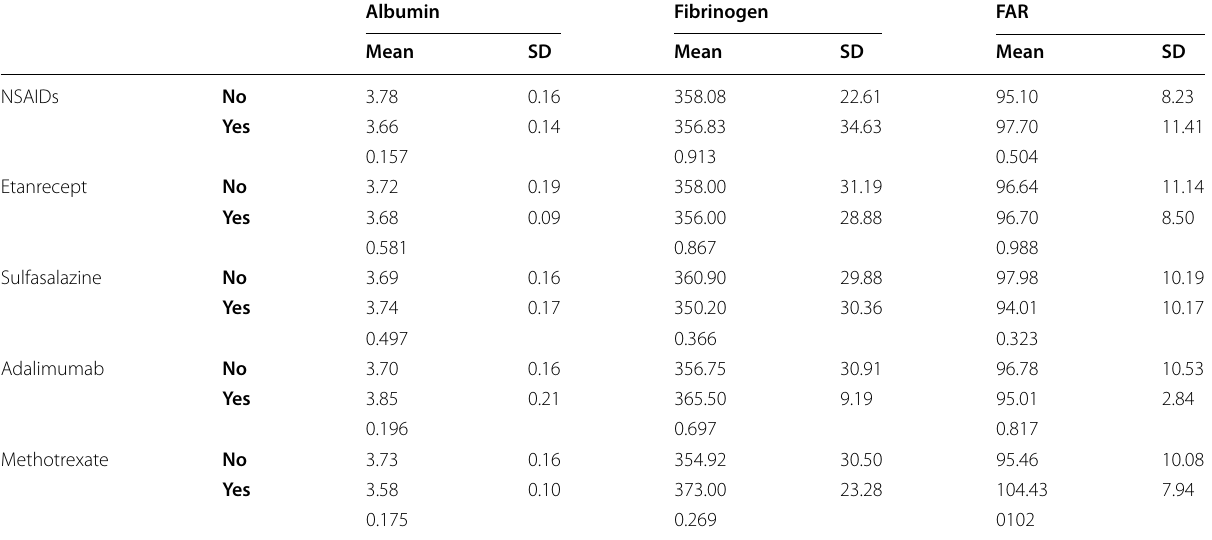
Table 8 Comparison of albumin, fibrinogen levels, and FAR according to the received medications among all studied